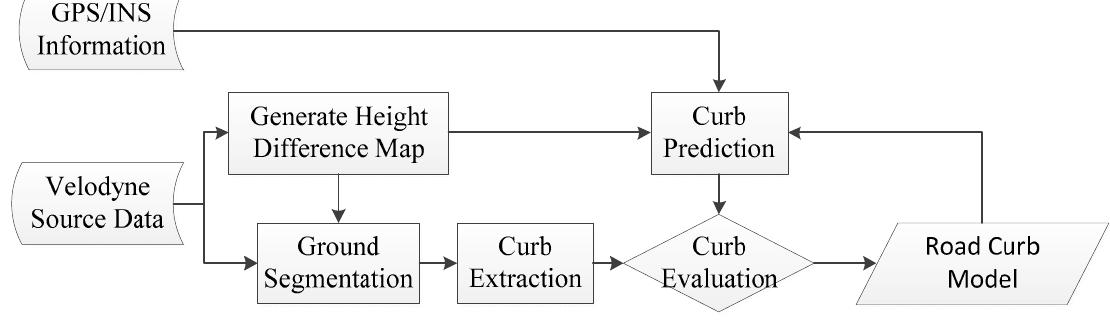
Figure 1. Framework for road curb detection and tracking.